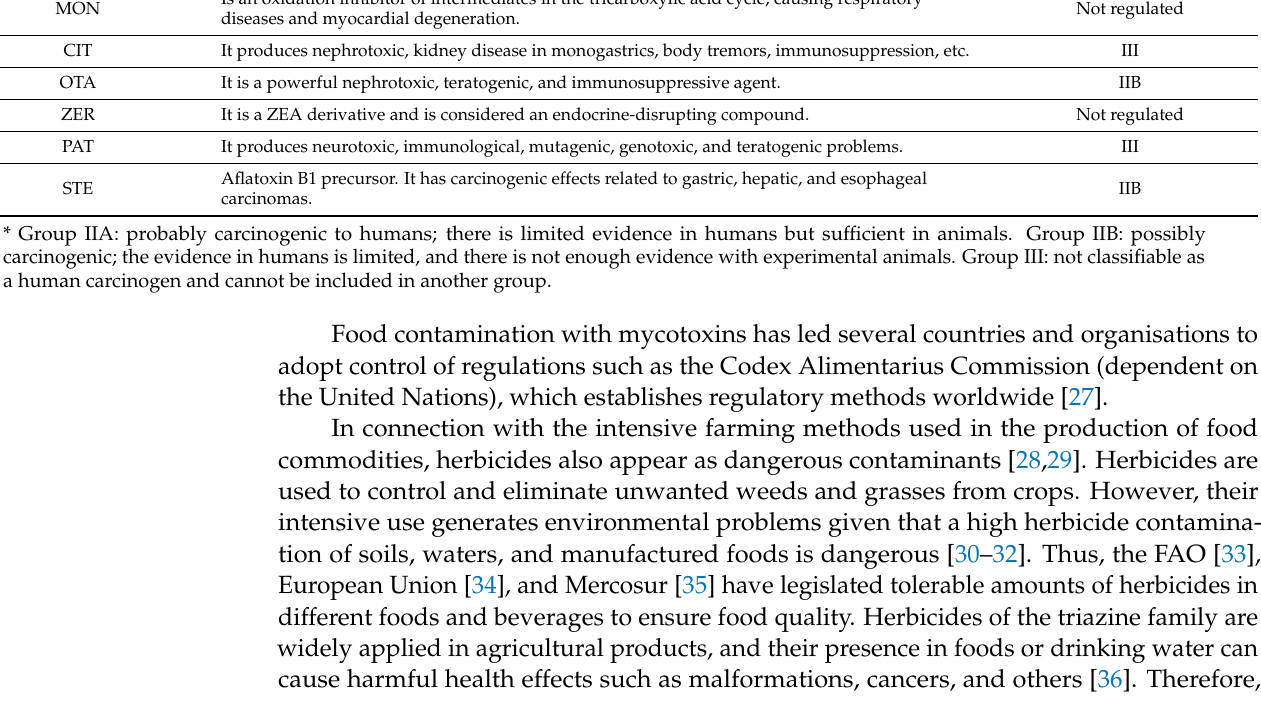
Table 1. IARC classification and effects produced by different mycotoxins. See the abbreviation list at the end of the article. Mycotoxins Effects IARC Classification *